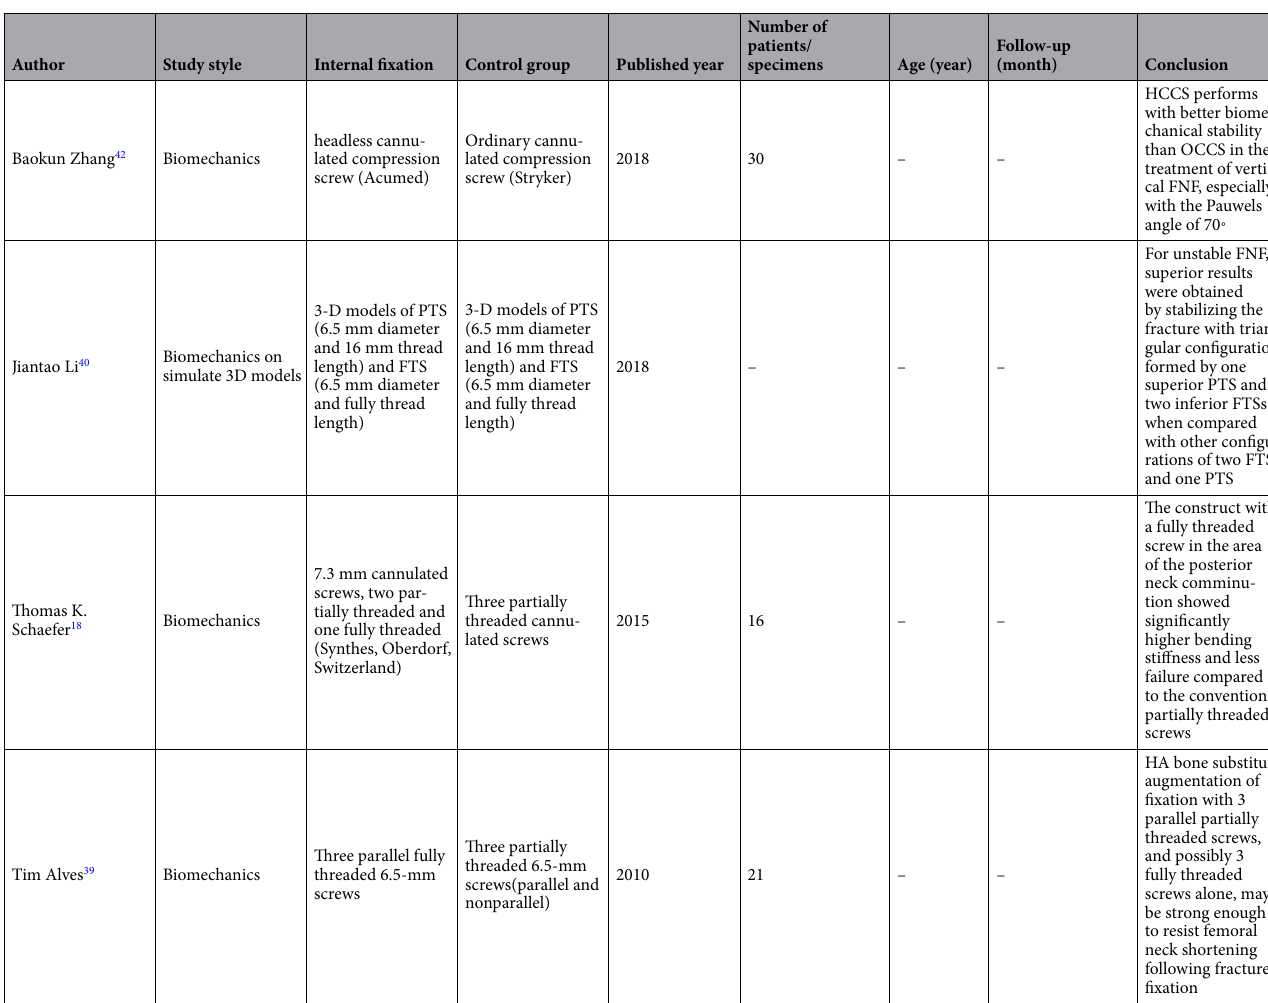
Table 10. Studies on fully threaded cannulated screws in the fixation of